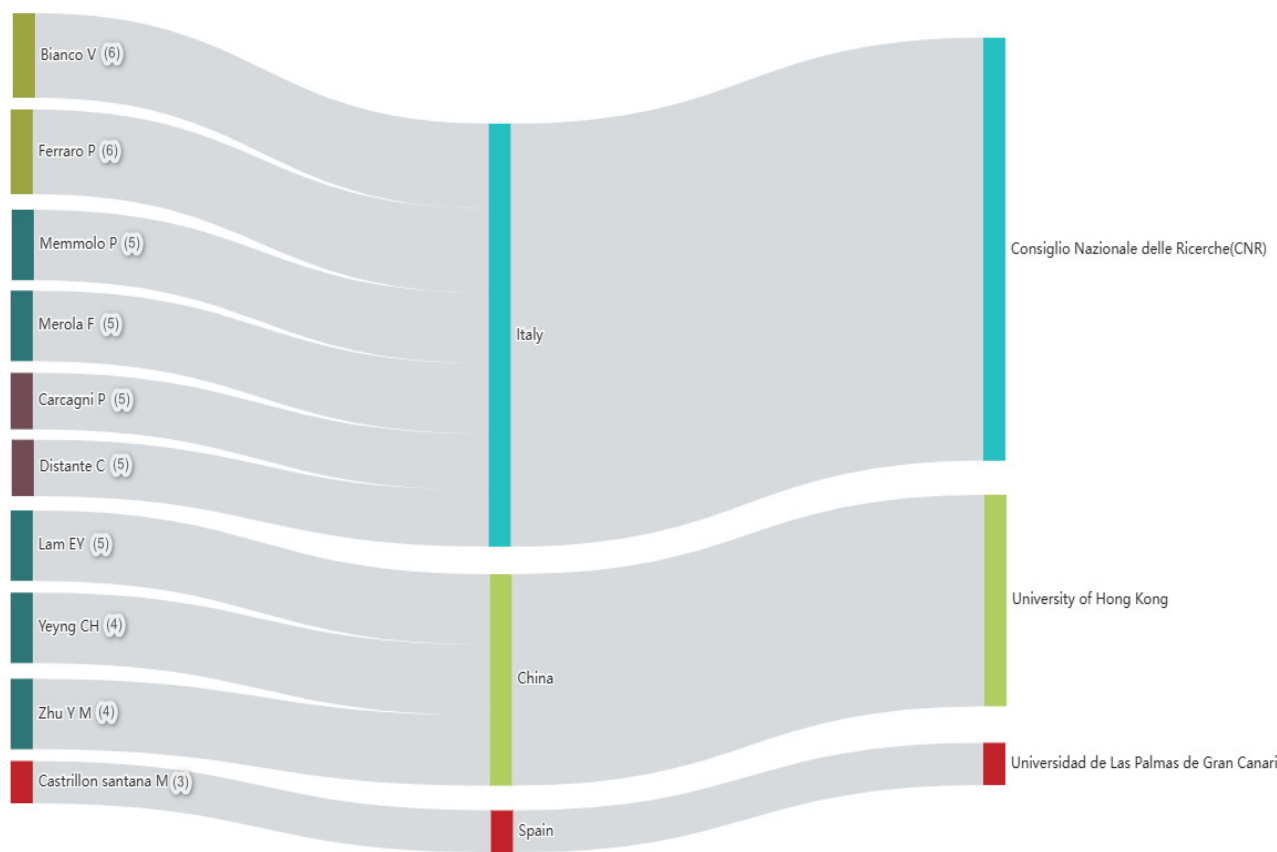
Figure 11. The most active authors from 2018 to 2022.